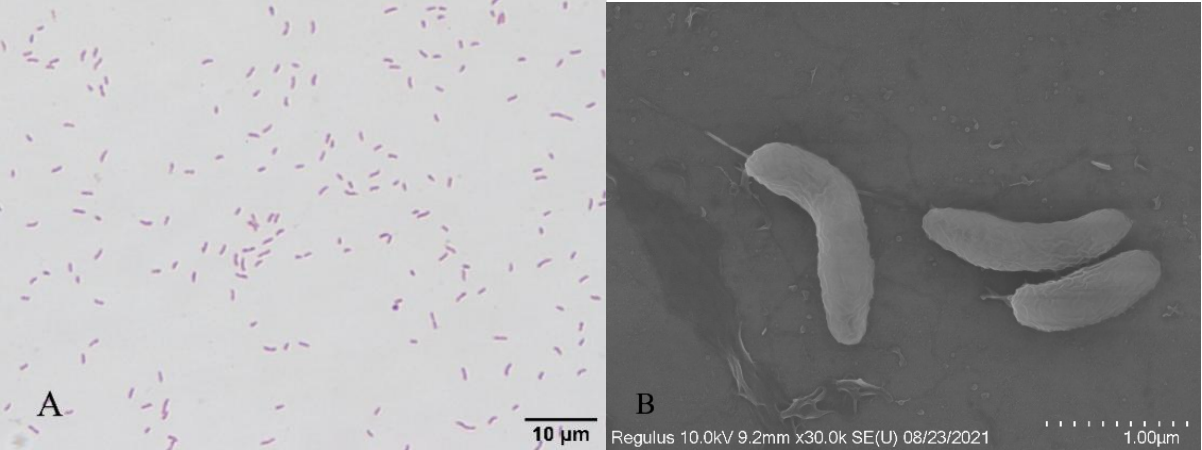
Figure 2. Gram staining and scanning electron microscopy of bacterium H-701: ( A ) Gram staining (bar scale: 10 µm); ( B ) Scanning electron microscopy (bar scale: 1 µm).